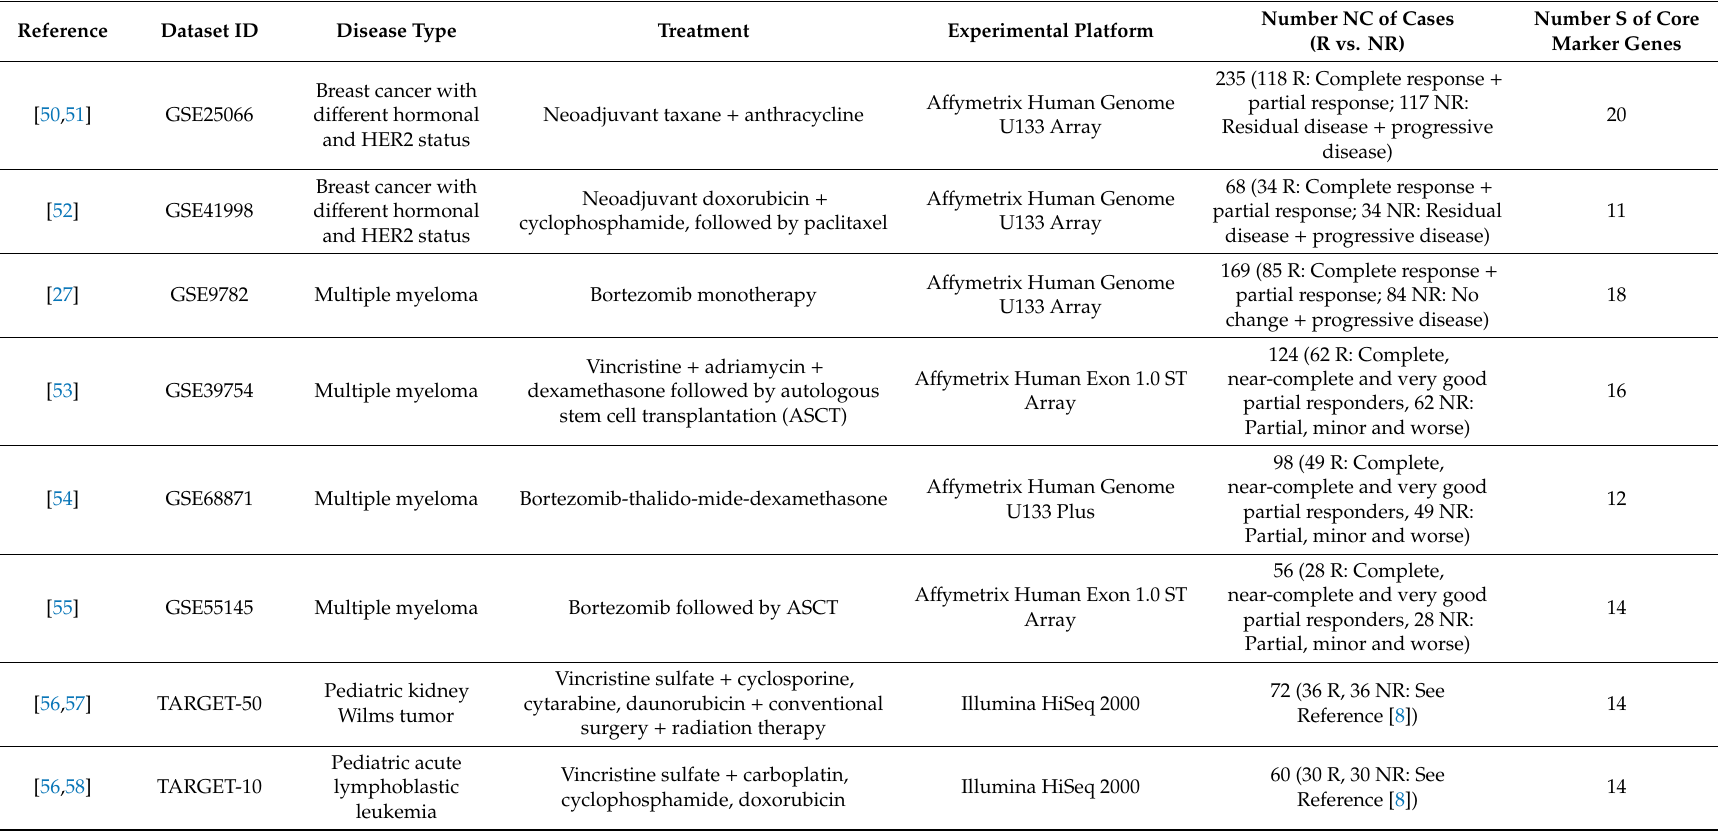
Table 6. Clinically annotated gene expression datasets used in this